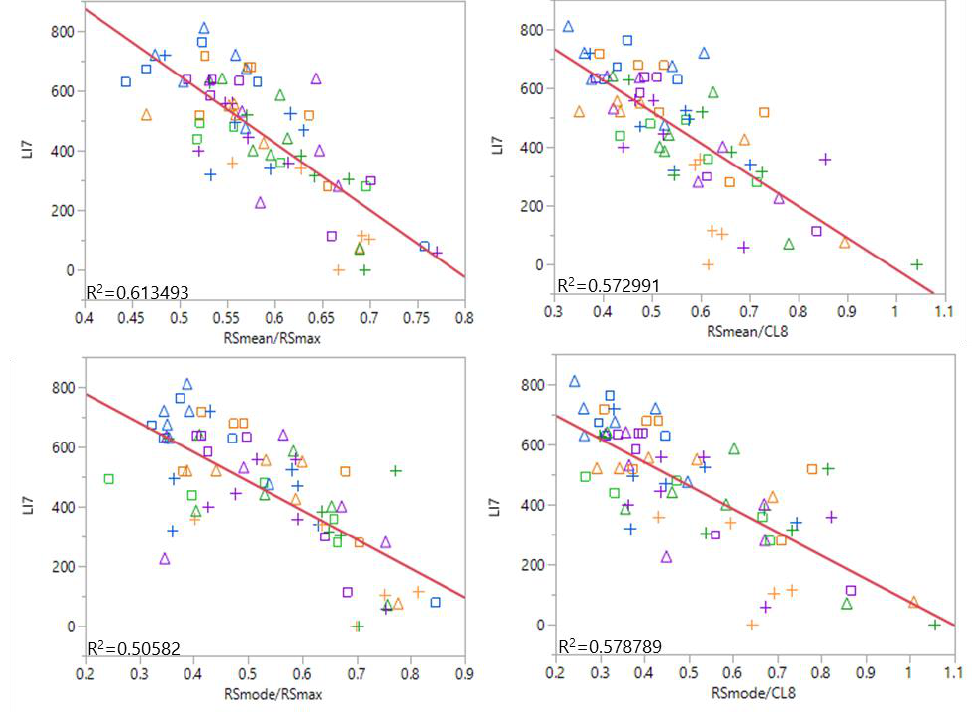
Figure 7. Regressions of remotely sensed lodging index values vs. ground-based lodging index (LI) values measured in the same week (LI-7). Mean and modal pixel height value divided by the maximum pixel height value (top left and bottom left, respectively) or by the actual culm length (CL) measured in the field in week 8 (top right and bottom right, respectively). Squares, triangles, and pluses represent 9 kg / ha, 6 kg / ha, and 3 kg / ha sowing rates, respectively. Purple, blue, orange, and green shapes represent accessions RTC-400, RTC-2, RTC-361, and RTC-119, respectively. R 2 values are presented on each figure. All correlations were significant ( P < 0.001).